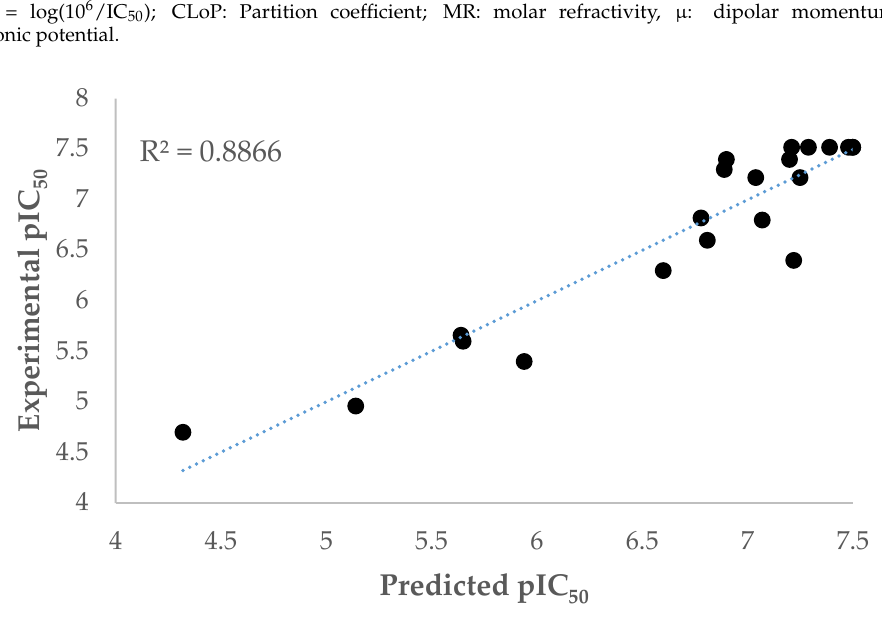
Figure 3. Experimental pIC 50 vs predicted pIC 50 using Equation (3).